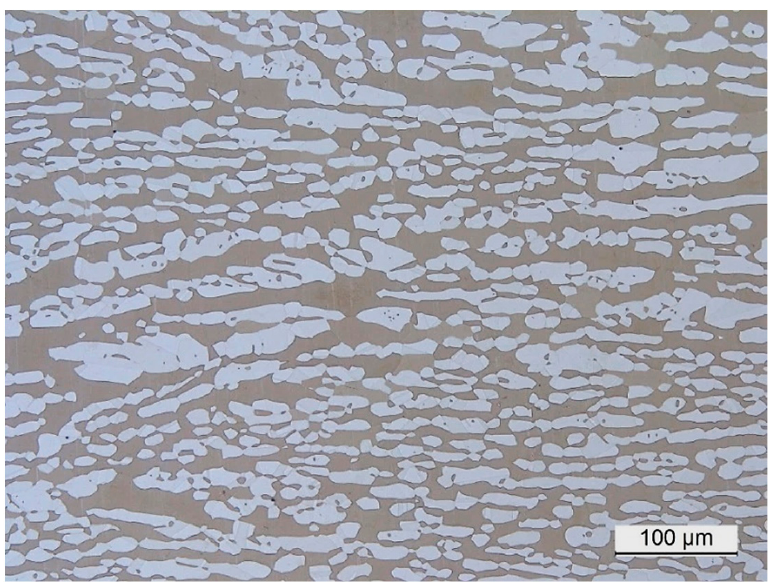
Figure 1. Microstructure of the building plate (austenite is white, ferrite is brownish).